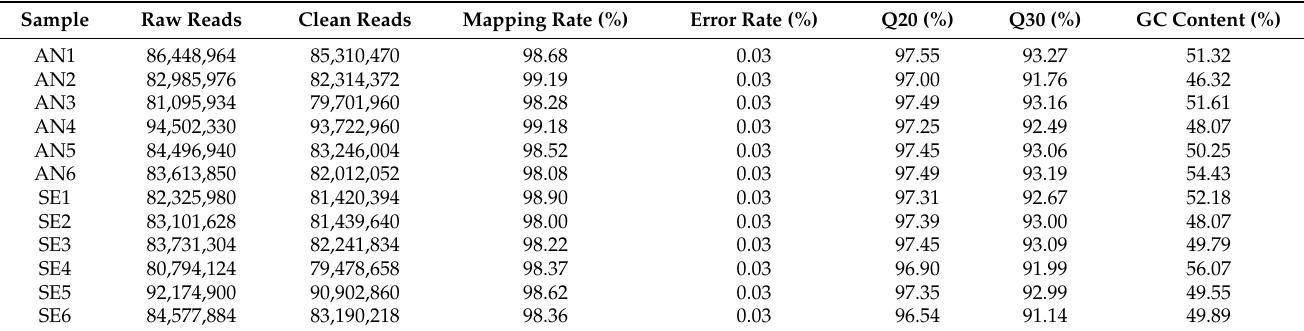
Table 1. Summary of the circRNA library.